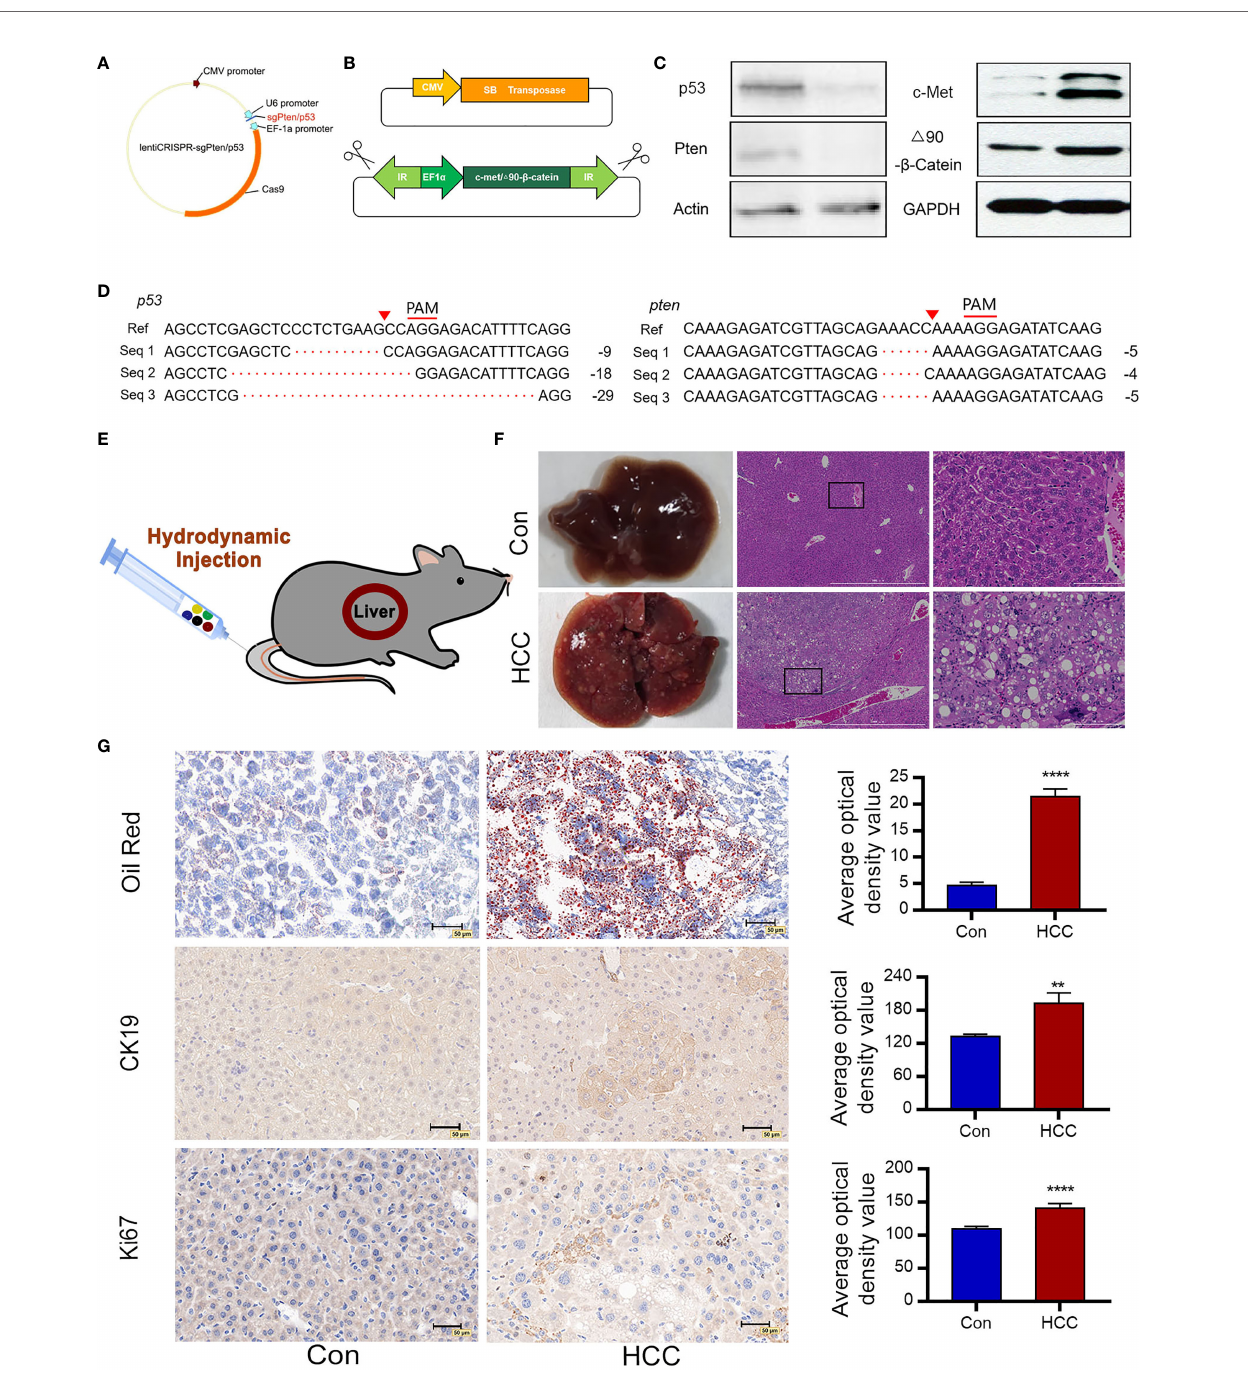
FIGURE 1 | Construction of plasmids and induction of liver tumors following hydrodynamic gene transfection. (A) Construction of lentiCRISPRv2/sgRNA plasmids expressing Cas9 and sgPten/p53. (B) Schematic diagram of SB transposase-associated plasmids. The SB transposase transfers a gene in the transposon cassette into a host genome. (C) Cell genomic DNA sequence of 3T3 cells analyzing deletion mutations of p53 and Pten. Seq 1-3 represent cell genomic DNA read sequences of NIH 3T3 cells knockdown by CRISPR/Cas9. The proto-spacer adjacent motif (PAM) sequences is denoted by red lines. Red triangles indicate the predicted DNA cleavage sites. (D) Immunoblots showing loss-of-function of p53 and Pten and overexpressions of c-Met and △ 90- b -catenin. Actin and GAPDH are used as control. (E) Saline containing fi ve plasmids are injected into the tail vein of mice via HDI (n=10 for each group). (F) Representative macroscopic images of liver tumors observed in C57